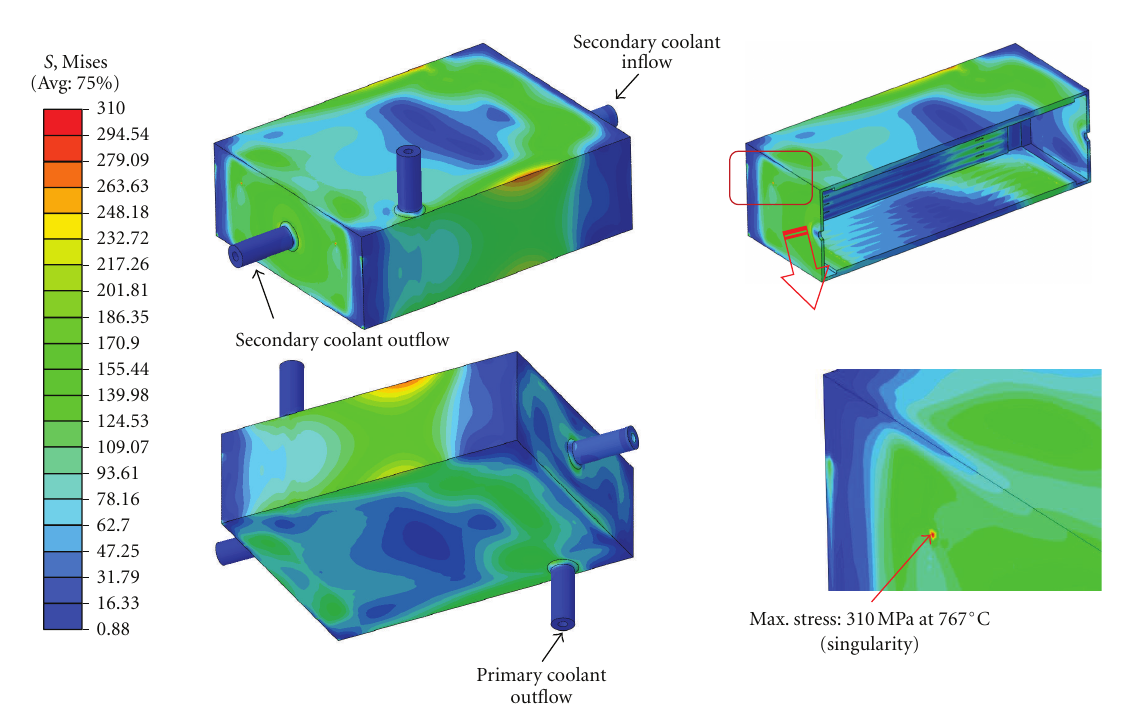
Figure 11: Contact condition.